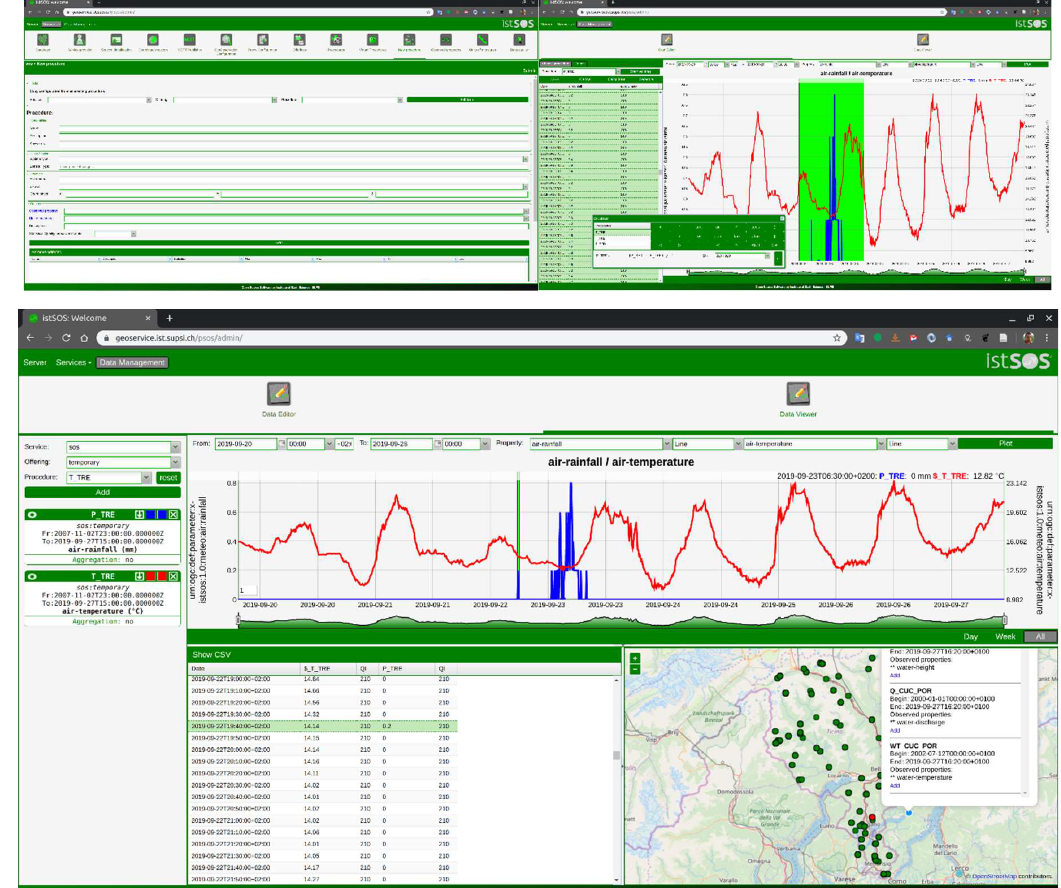
Figure 1. Graphical user interface of the istSOS software. At the top-left a screenshot of the administration interface to register a new sensor to the monitoring network: specifics buttons opens manipulate and validate data. At the bottom, the data viewer interface to explore data in space and time by observed